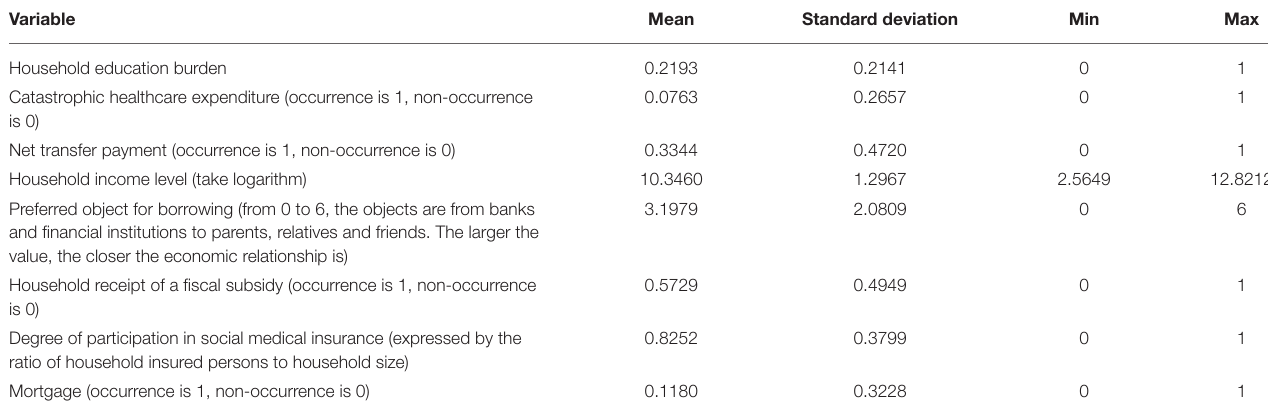
TABLE 1 | Descriptive